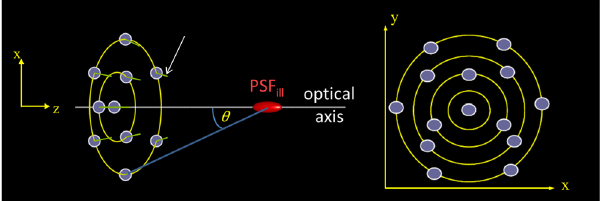
Figure 1. Schematic arrangement of light sources in the Distributed Aperture Microscope (DAM). Violet discs: Individual sources S 1 , S 2 , … S K , … S N of coherent, collimated light at positions (x K , y K , z K ) with defined phase and polarization relations emitting the light in defined directions (green); the red “spot” indicates the joint focal illumination distribution (i.e. the “focal volume” or the “observation volume of the illumination spot”) produced by the constructive interference of the collimated waves. Altogether, the sources span a solid angle π θ Ω = − 2 [1 cos ( )] , corresponding to the numerical aperture of a conventional objective lens. In such a configuration the Point-Spread-Function (PSF ill ) of a conventional lens based illumination scheme may be